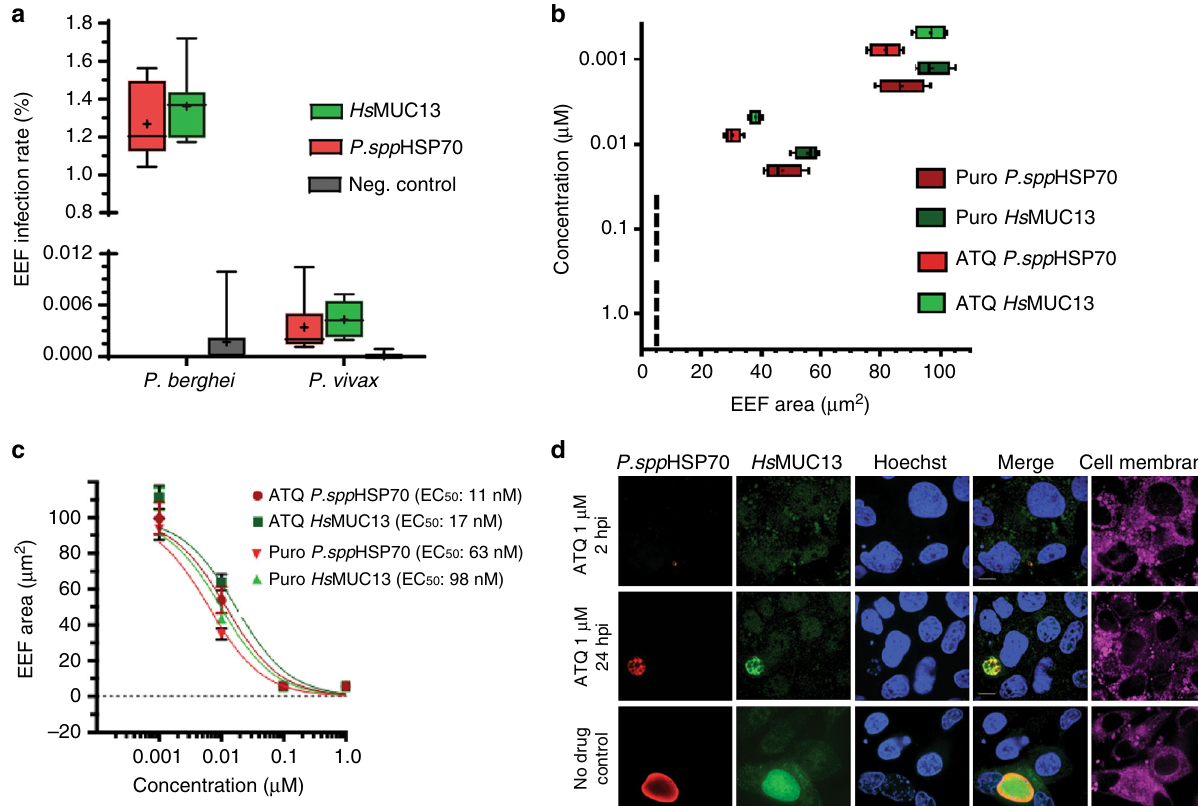
Fig. 4 MUC13 as a quantitative biomarker of Plasmodium EEF infection. a Counts of P. berghei or P. vivax EEF in HC04 cells by indirect immuno fl uorescence. Negative controls with no primary antibodies were included. Parasite burden was estimated by counting at least 240,000 cells, via high content imaging. Data ( n = 3) presented with the mean indicated by a “ + ” and error bars indicating the 5 – 95% con fi dence interval. b Effect of atovaquone (ATQ) and puromycin (PURO) treatment (2 hpi) on cell area (growth) of P. berghei EEF in HC04 at 48 hpi. Data ( n = 4) presented with the mean indicated by a “ + ” and error bars indicating the 5 – 95% con fi dence interval. c Dose – response curves of P. berghei EEF in HC04 cells for atovaquone (ATQ) and puromycin (PURO). 95% con fi dence interval for EC 50s = ATQ P. spp HSP70, 8.98 – 15.82; ATQ Hs MUC13, 11.18 – 26.05; PURO Hs MUC13, 6.29 – 15.29; PURO P. spp HSP70, 5.01 – 7.92. Data presented as mean ± SD, n = 2 with 5 – 95% con fi dence intervals indicated. d Representative images of P. berghei EEF in HC04 cells (48 hpi) treated (2 hpi) with 1 μ M of atovaquone, puromycin, or DMSO. P. berghei was labeled with P. ssp HSP70 mouse polyclonal antibody (dilution 1:500, 1 mg/ml stock). HC04 cells were labeled with a rabbit polyclonal antibody (dilution 1:500, 1 mg/ml stock) recognizing the intracellular region of Hs MUC13 (MUC13 antibody #2 — LifeSpan BioSciences #LS-C345092). Primary antibody detection was performed with goat anti-mouse (Alexa Fluor 647, red) and goat anti-rabbit (Alexa Fluor 488, green) antibodies. Nuclei and cell membranes were stained with Hoechst 33342 (blue) and CellMask deep red (magenta), respectively. Scale bar 10 μ m; 100×